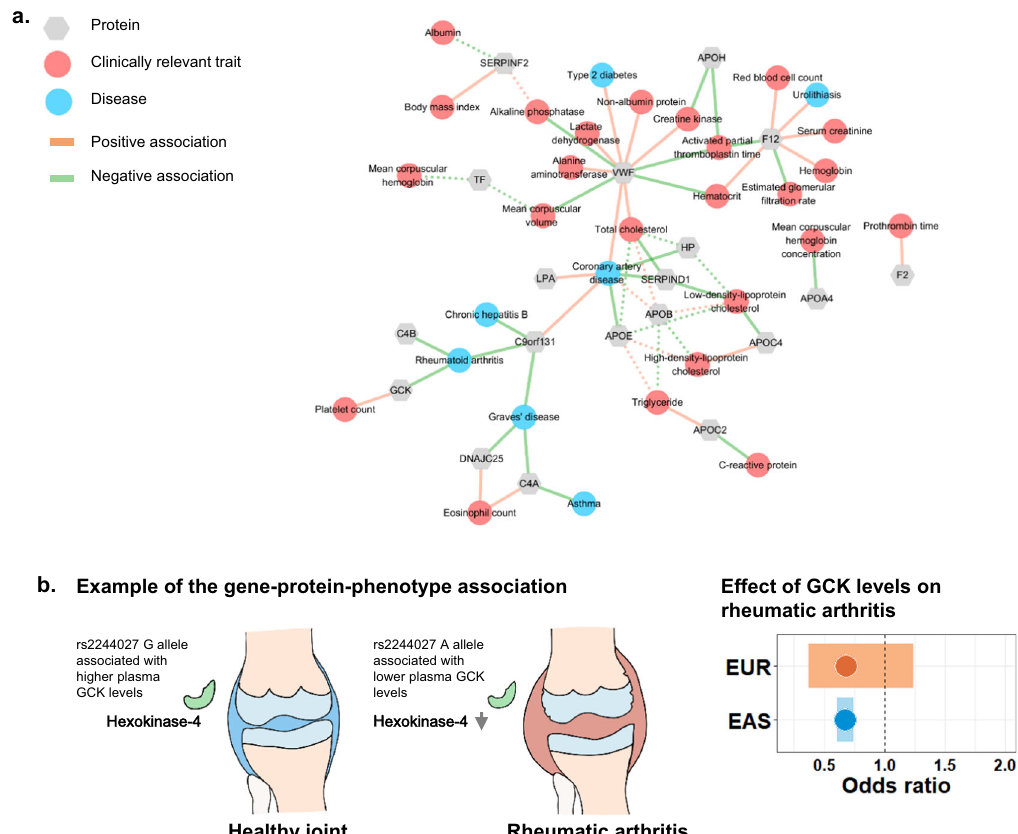
Fig. 6 | Network representation of potential gene – protein – phenotype asso- ciations. a Associations between proteins and diseases, as well as clinically rele- vant traits found by Mendelian randomization analysis and colocalization analysis ( P <0.05 after Bonferroni correction). The solid line represents